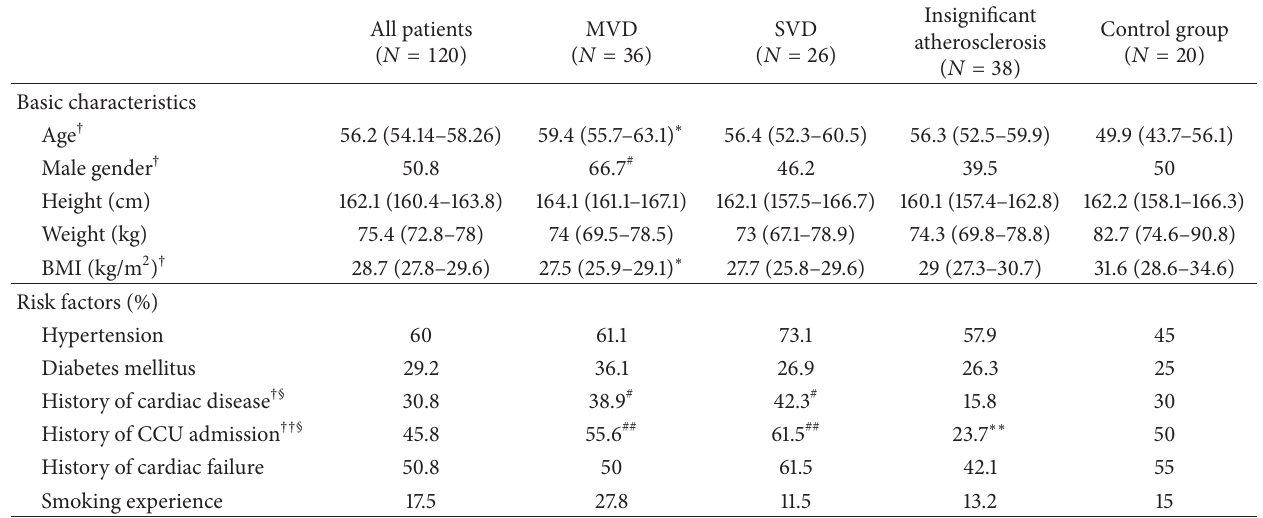
Table 1: Description of patients with comparison of CAD (basic characteristics and risk factors).